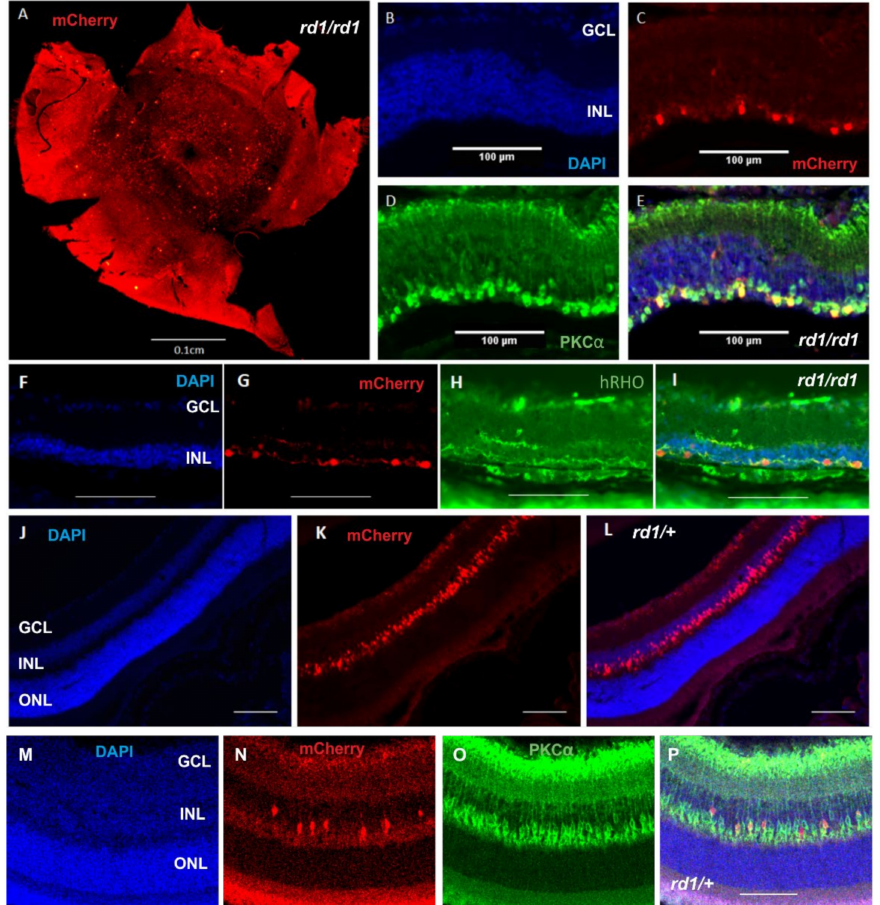
Figure 1. Characterisation of a Grm6 Cre Rd1 mouse treated with human rod opsin. ( A ) A representa- tive wholemount retinal image of a Grm6 Cre/+ rd1/rd1 mouse following an intravitreal injection of AAV2(4Y-F)-CMV-DIO-hRHO-T2A-mCherry displaying widespread transduction of the mCherry reporter. ( B – E ) Cross section of a rod opsin-treated retina of a Grm6 Cr/+e rd1/rd1 mouse displaying mCherry co-localisation within PKC α -expressing bipolar cells. ( B ) DAPI (in blue), ( C ) mCherry (in red), ( D ) PKC α (in green), ( E ) merge of B, C and D. ( F – I ) Cross section of a rod opsin-treated Grm6 Cre rd1/rd1 mouse displaying mCherry co-localisation with human rod opsin (hRHO). ( F ) DAPI (in blue), ( G ) mCherry (in red), ( H ) rod opsin (in green), ( I ) = merge of F, G and H. ( J – L ) A cross section of a rod opsin-treated retina of a Grm6 Cre rd1/+ mouse. ( F ) DAPI (in blue), ( G ) mCherry (in red), ( H ) = merge of ( F , G ). ( M – P ) Cross section of a rod opsin-treated Grm6 Cre rd1/+ mouse displaying mCherry co-localisation with PKC α . ( M ) DAPI (in blue), ( N ) mCherry (in red), ( O ) PKC α (in green), ( P ) merge of M, N and O. Scale bars = 100 µ m. ONL = outer nuclear layer; INL = inner nuclear layer; GCL = ganglion cell